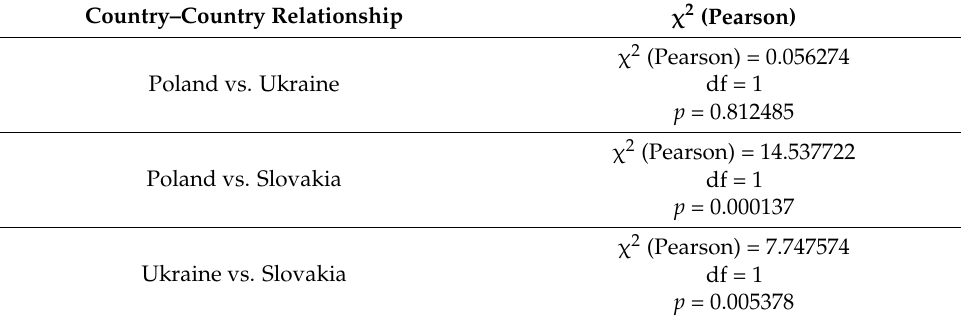
Table 6. Results of χ 2 test for the relationship between the studied countries in the area of knowledge of ZW concept.